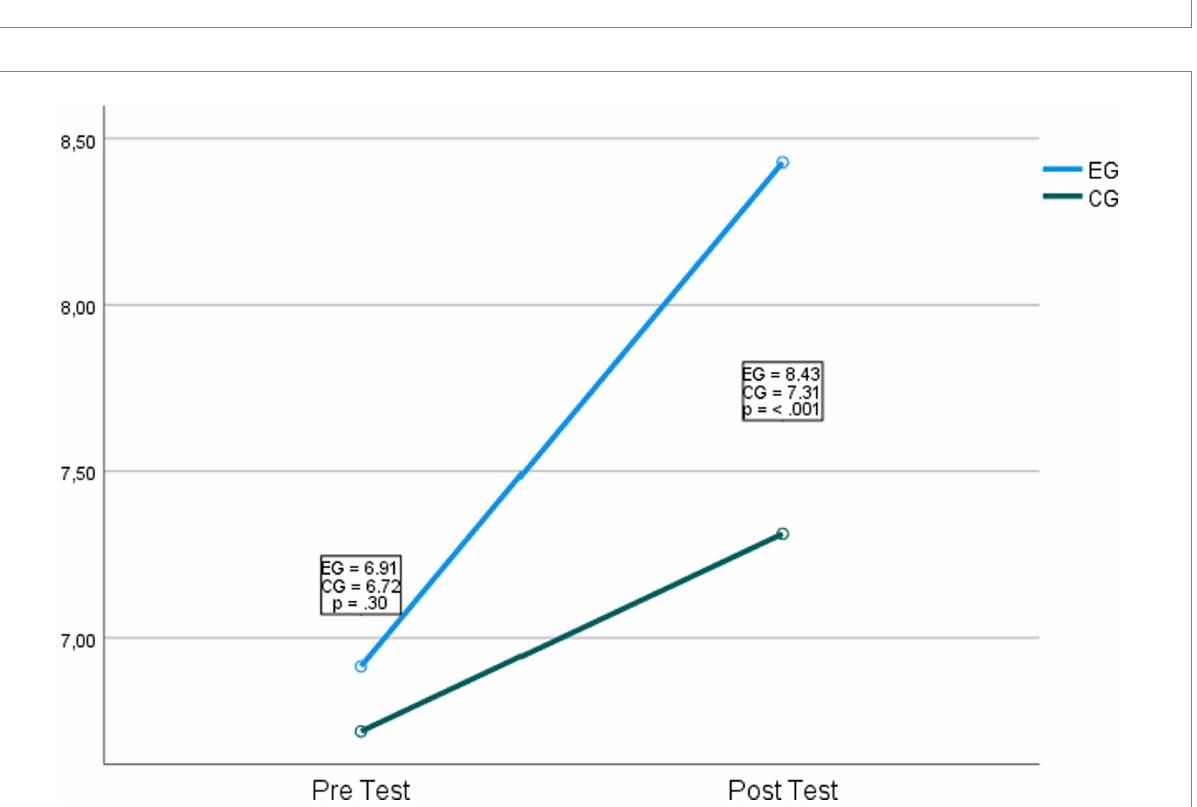
FIGURE 4 Comparison of the control and experimental groups concerning order.